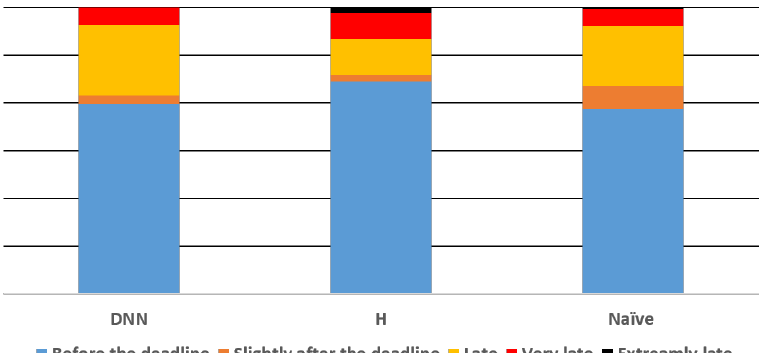
Figure 4. Lateness distribution for the three algorithmic solutions. Error bars are too small to be presented. Slightly over the deadline = less than 15 min after the deadline; Late = between 15 and 45 min past the deadline; Very late = between 45 and 60 min past the deadline; Extremely late = more than 1 h past the deadline